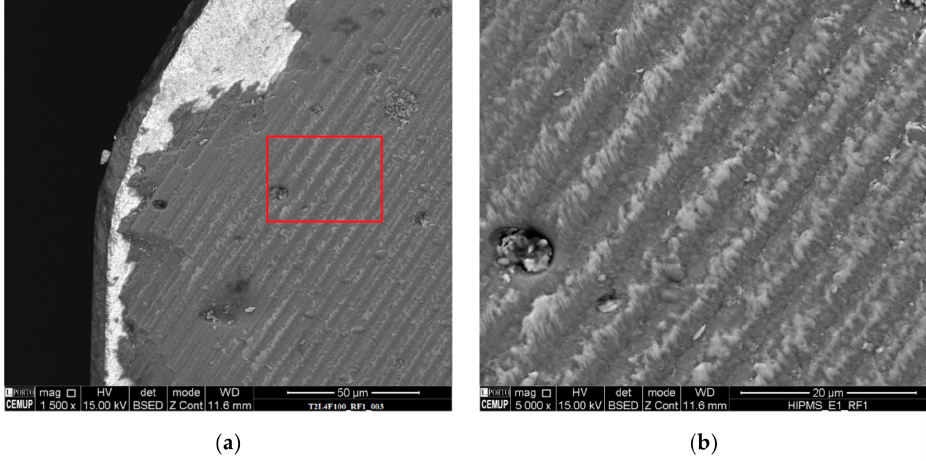
Figure 5. Rake face, with a 1500 × magnification, of the ( a ) T2L4F100 tool; ( b ) magnification of the highlighted area.